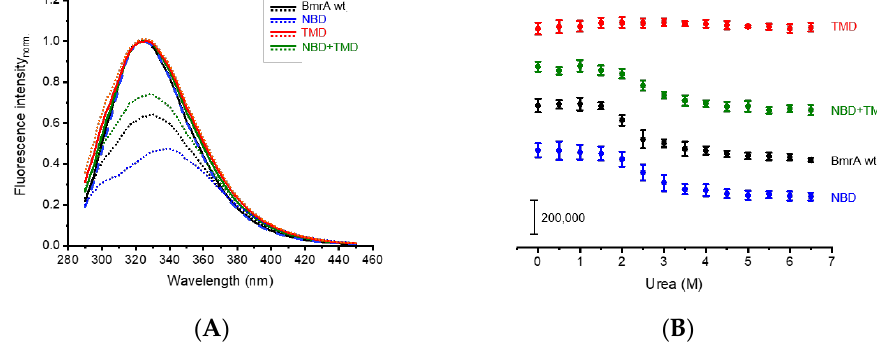
Figure 2. Urea denaturation of full-length BmrA wt and isolated domains. ( A ) Normalized fluorescence emission spectra of BmrA wt (black), NBD (blue), TMD (red), and NBD + TMD (green) of the native protein (lines) and the protein exposed to 6.5 M urea (dotted lines). The shown Trp fluorescence emission spectra constitute the mean of three independent protein purifications (without standard deviation (SD)). ( B ) Changes in the fluorescence intensities of full-length BmrA wt (black), NBD (blue), TMD (red), and NBD + TMD (green) at different urea concentrations were determined at a fixed wavelength (BmrA wt: 322 nm; NBD: 323 nm; TMD: 323 nm; NBD + TMD: 323 nm). Data points represent the mean of three independent purifications (±SD). The curves are shifted vertically for clarity.